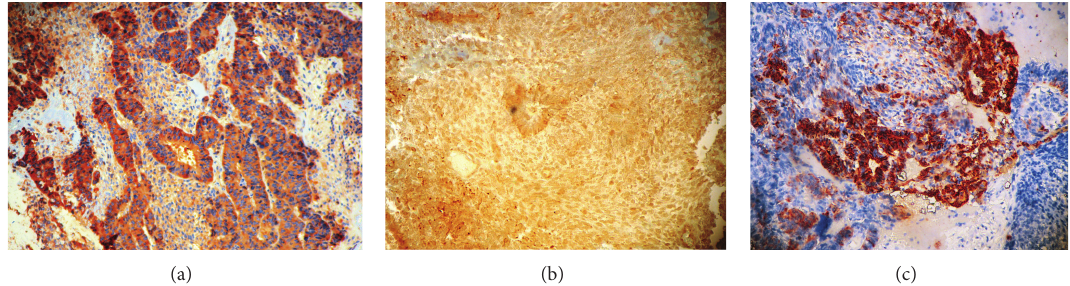
Figure 3: Immunohistochemical analysis showing positive staining for (a) NSE and (b) GFAP, with focal positive staining for (c) S100